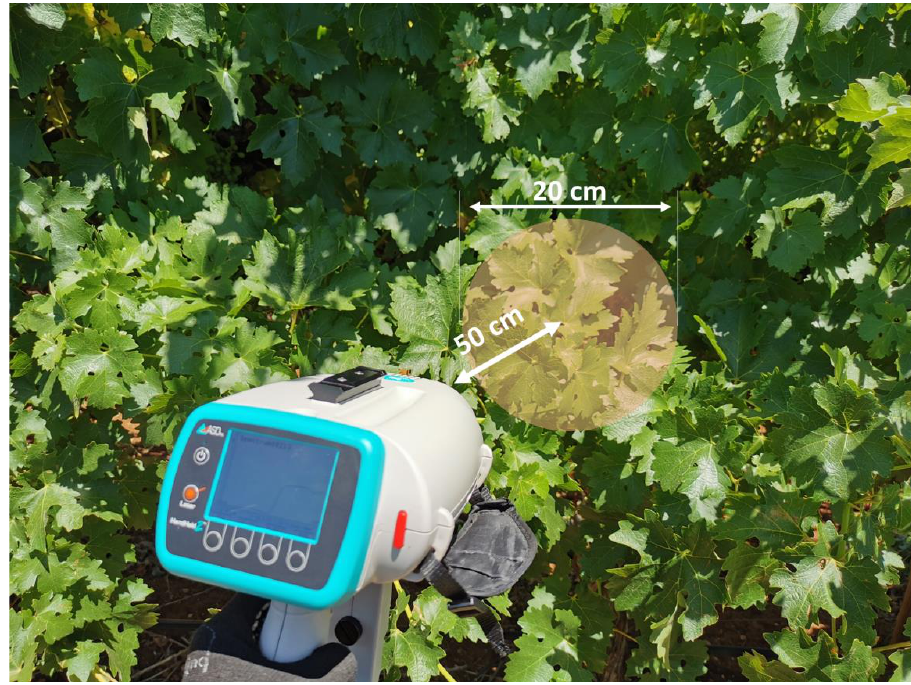
Figure 1. Spectral data measurement. The yellow shaded area shows the circular field of view of diameter of approx. 20 cm based on the approx. 0.5 m horizontal measurement distance.